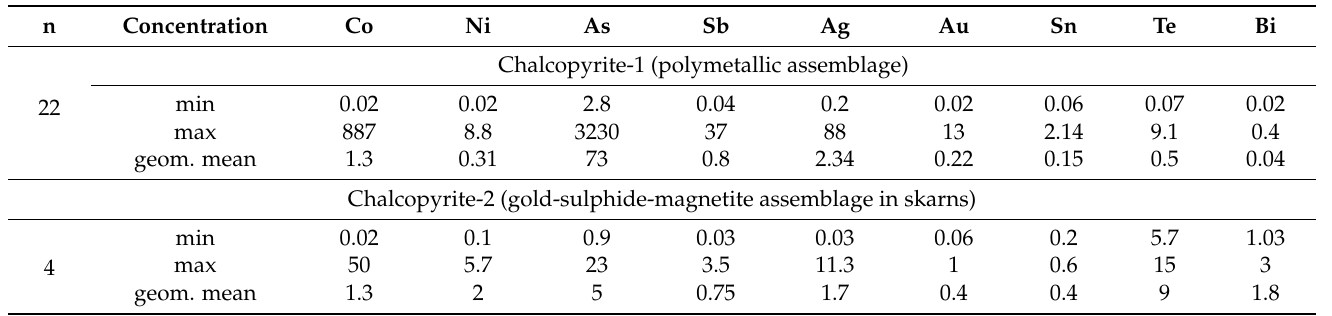
Figure 21. LA-ICPMS distribution map of impurity elements in pyrite grain from the polymetallic assemblage of the Novogodnee-Monto deposit (sample NM 46), scales in ppm. Chalcopyrite: Peak concentrations of As (up to 3230 ppm), Pb (up to 1050 ppm), Co (up to 887 ppm), Se (up to 109 ppm), Ag (up to 88 ppm), Au (up to 13 ppm), Ni (up to 9 ppm) and Sn (up to 2 ppm) are found in chalcopyrite-1 (Tables 16 and 17). Maxima of Zn (up to 145 ppm), Sb (up to 37 ppm), Te (up to 15 ppm) and Bi (up to 3 ppm) occur in chalcopyrite-2. The peaks of Pb, As, Zn, Te, Ag and Au on the LA-ICPMS profiles are probably related to the capture of small inclusions of galena, arsenopyrite, sphalerite, altaite, calaverite, native gold, hessite and petzite, which were found microscopically. Table 16. The trace element contents (ppm) in chalcopyrite of different assemblages of the Novogodnee-Monto deposit according to LA-ICPMS data.